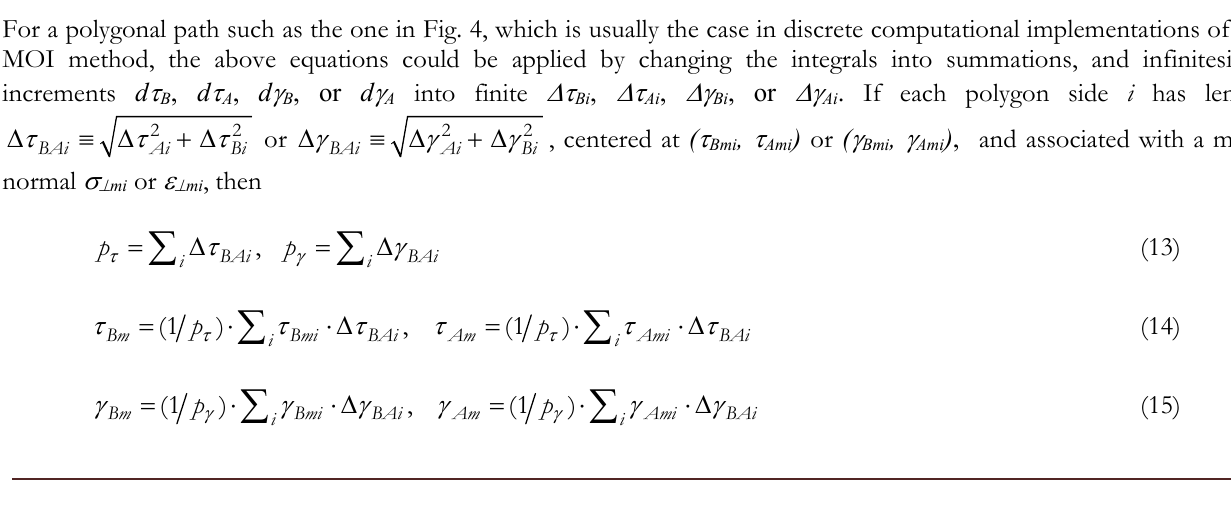
Figure 3: Stress path of a 2D shear-shear load history on a candidate plane (left) and its corresponding strain path (right), both assumed as homogeneous wires with unit